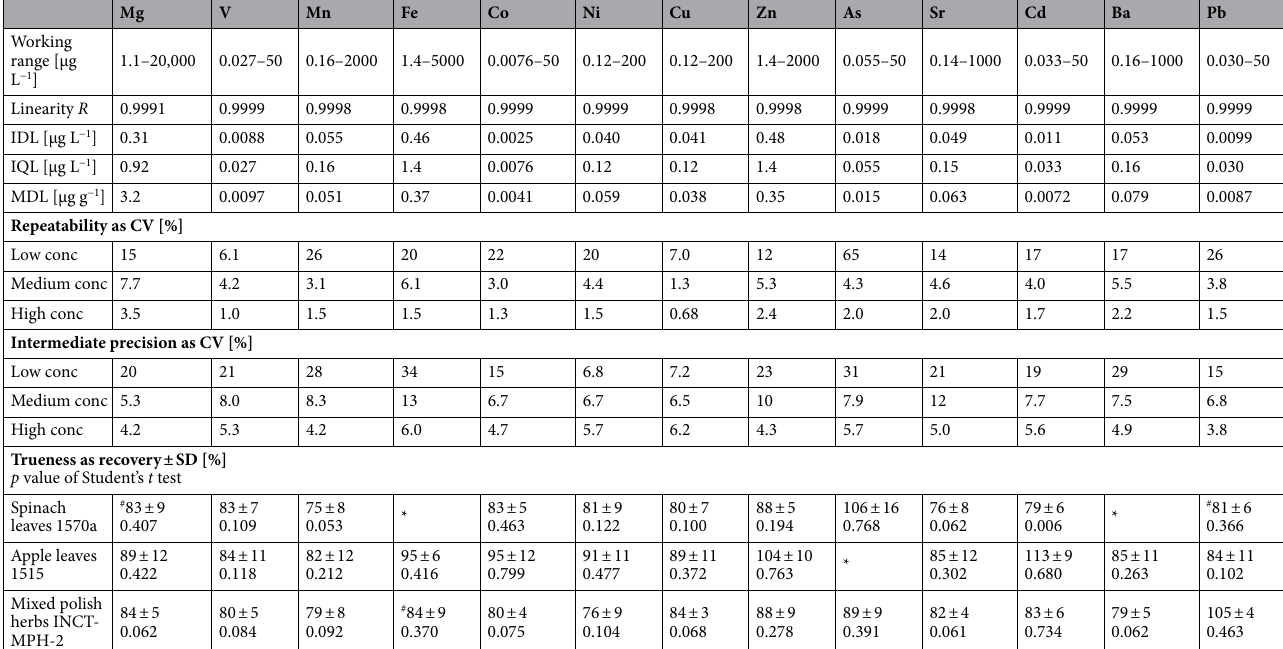
Table 3. The validation parameters of the developed analytical procedure for determination of 13 elements in roots of herbs. The IDL and IQL refer to the solution and MDL refers to the dry mass of roots. The low and high concentration refers to the standard solution with concentration close to the low limit of working range and the highest concentration standard, respectively. The medium concentration is (in µg L −1 ) 1.0 for V, Co, As, Cd and Pb, 10.0 for Ni and Cu, 100 for Mn, Fe, Zn, Sr and Ba, and 1000 for Mg. The Student’s p value refer to the probability of statistical significance between measured and certified value in CRM. *Element not stated in certificate; # Element with informative